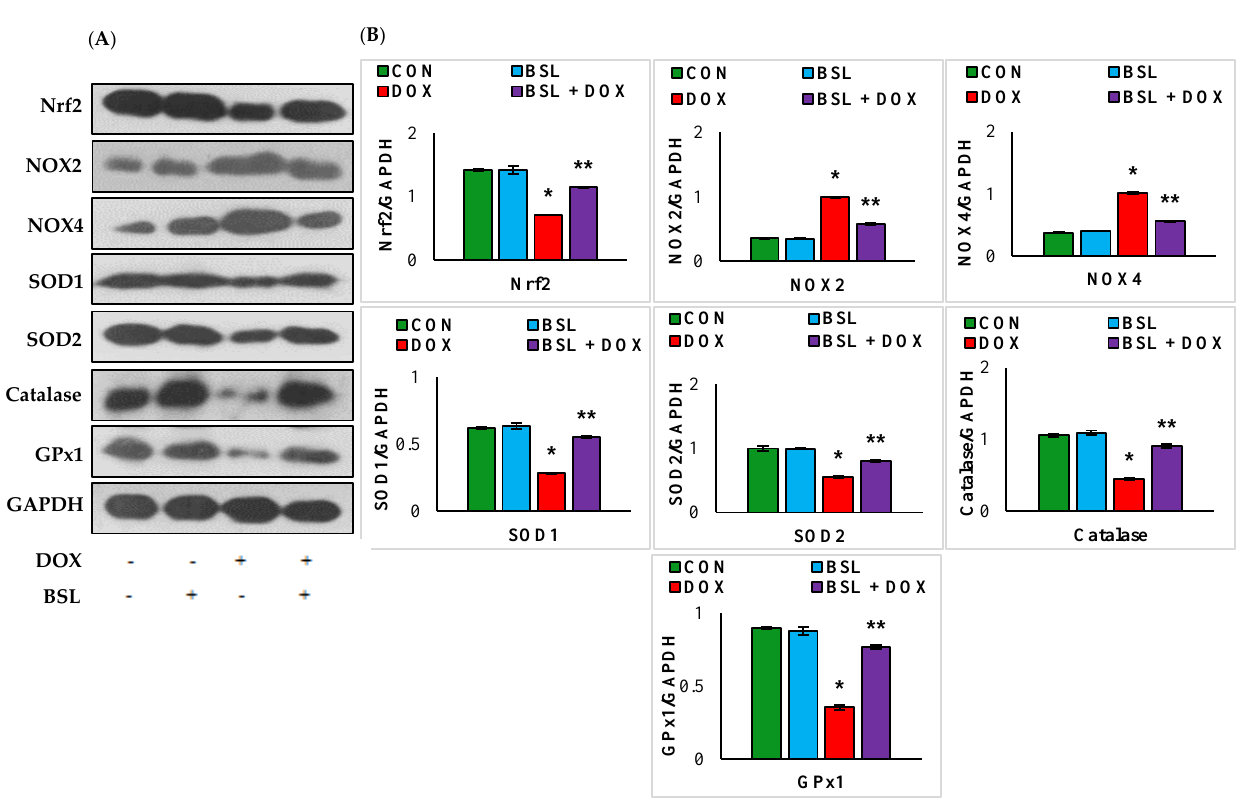
Figure 2. Effect of α -bisabolol on Nrf2 activation and expression levels of NADPH oxidases/antioxidants in DOX-injected rats. ( A ) Representative images of Western immunoblot analysis for Nrf2, NOX2, NOX4, SOD1, SOD2, catalase, and GPx1. ( B ) Densitometric analysis of testicular protein expression levels of Nrf2, NOX2, NOX4, SOD1, SOD2, catalase, and GPx1 assessed by Western blot analysis. Columns not sharing a common symbol (*, **) differ significantly from each other (* p < 0.05 vs. normal control, ** p < 0.05 vs. DOX control), CON-Control, BSL- α -Bisabolol, DOX-Doxorubicin, BSL + DOX- α -Bisabolol + Doxorubicin.